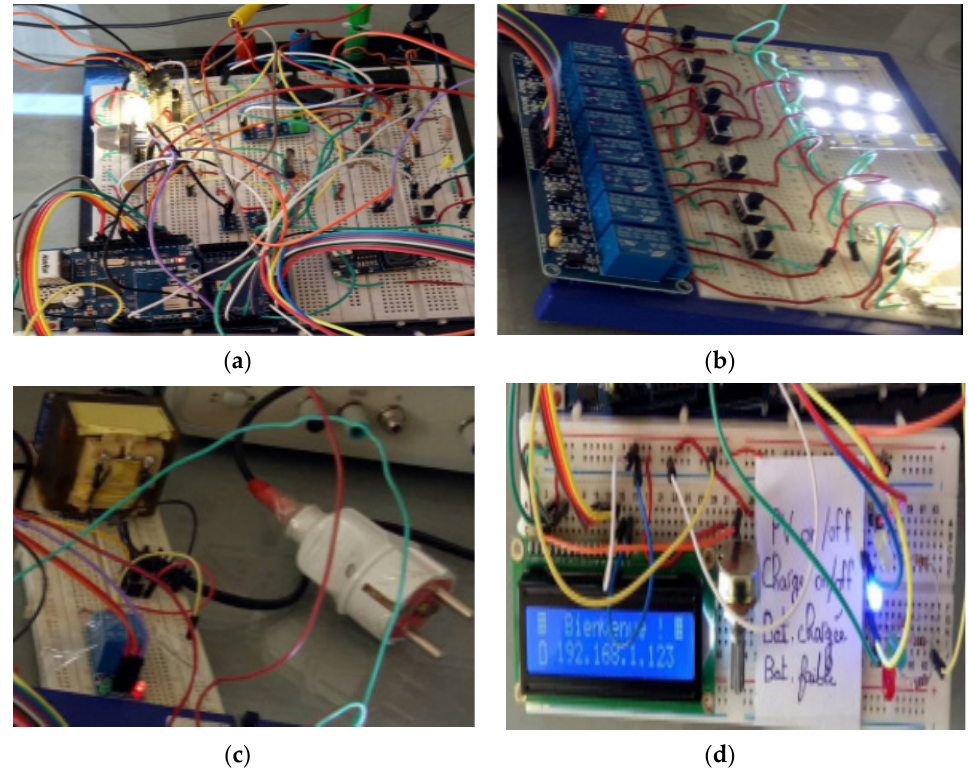
Figure 5. Different parts of the prototype where ( a ): PWM charge controller, ( b ): the divided loads in three groups, ( c ): a relay and an AC–DC converter, ( d ): LCD display mainly containing the IP address which allows the users to access the graphical interface.